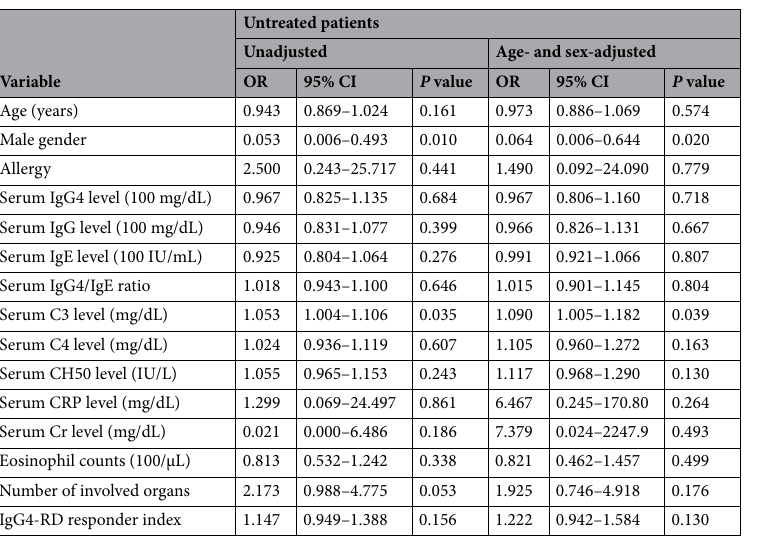
Table 3. Odds ratio for risk of spontaneous improvement of IgG4-RD: unadjusted and age- and sex-adjusted logistic regressions. Conversion factor for Cr: mg/dL to μmol/L, × 88.4 ANA anti-nuclear antibody, Cr creatinine, CRP C-reactive protein, IgG immunoglobulin G, IgG4 immunoglobulin G4, IgE immunoglobulin E.